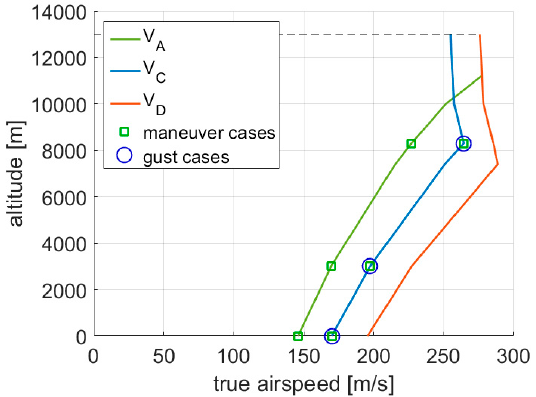
Figure 15. Selected flight conditions in the design envelope.